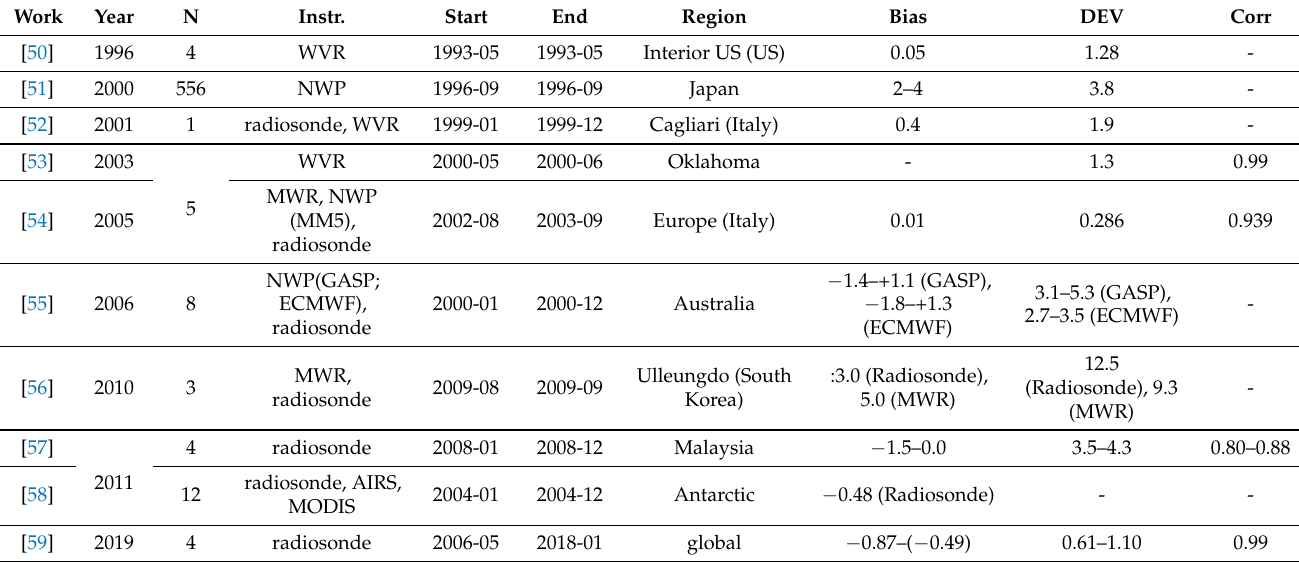
Table 1. Summary of studies on validation of GNSS measurements. Column Year is the publication year. N is the number of stations. Instr. is the instruments (besides ground-based GNSS) used in the study. Start and End mark the period considered in the study, in year-month format. Bias is the bias in mm, and DEV is the RMSE or SD also in mm. Corr is the correlation coefficient